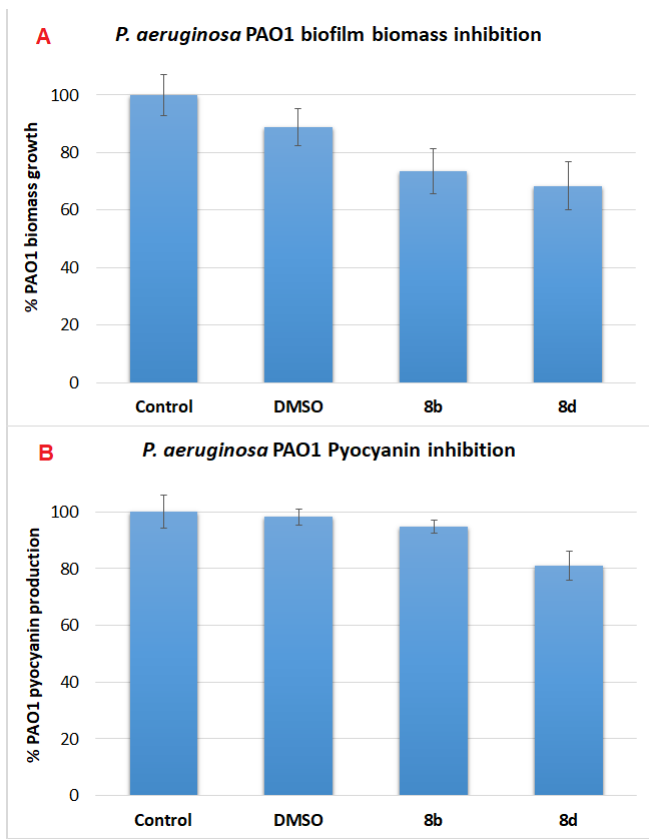
Figure 2. ( A ) Percentage biofilm mass inhibited by 8b , d with blank as control and DMSO as comparison with P. aeruginosa (PAO1) planktonic cultures. ( B ) Percentage pyocyanin inhibited by 8b and 8d with respect to the DMSO control using P. aeruginosa (PAO1) planktonic cultures.